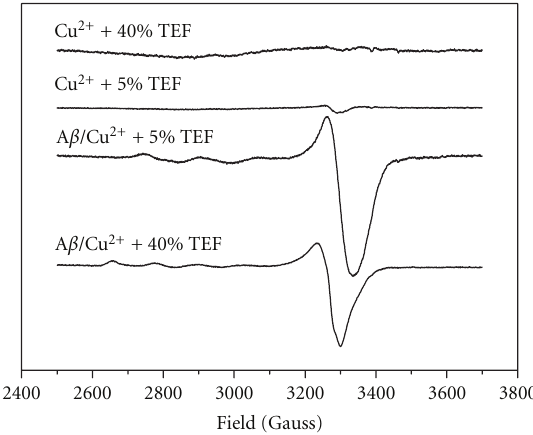
Figure 3: EPR spectra for Cu 2+ only, A β 40/Cu 2+ in either 5% or 40% TFE. The characteristic g (cid:5) and g ⊥ hyperfine peaks appeared in 5% and 40% TFE represent that copper ion coordinates with A β 40 in a 3N1O mode. The characteristic bands in 40% TFE are slightly ) A β 40/Cu 2+ in shift downfield compared with the hyperfine peaks appeared in 5% (cid:0) ) TFE, suggesting that A β 40 adopts di ff erent conformationin 5% and (cid:3) 40%